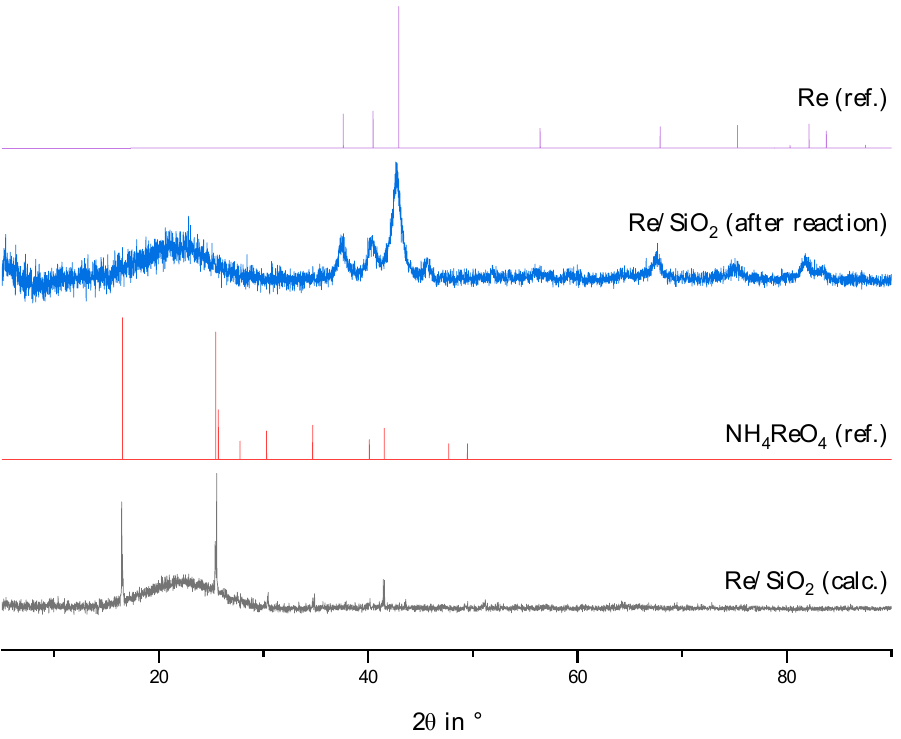
Figure A5. P-XRD of calcined rhenium catalyst before reaction (calc.) and after reaction.